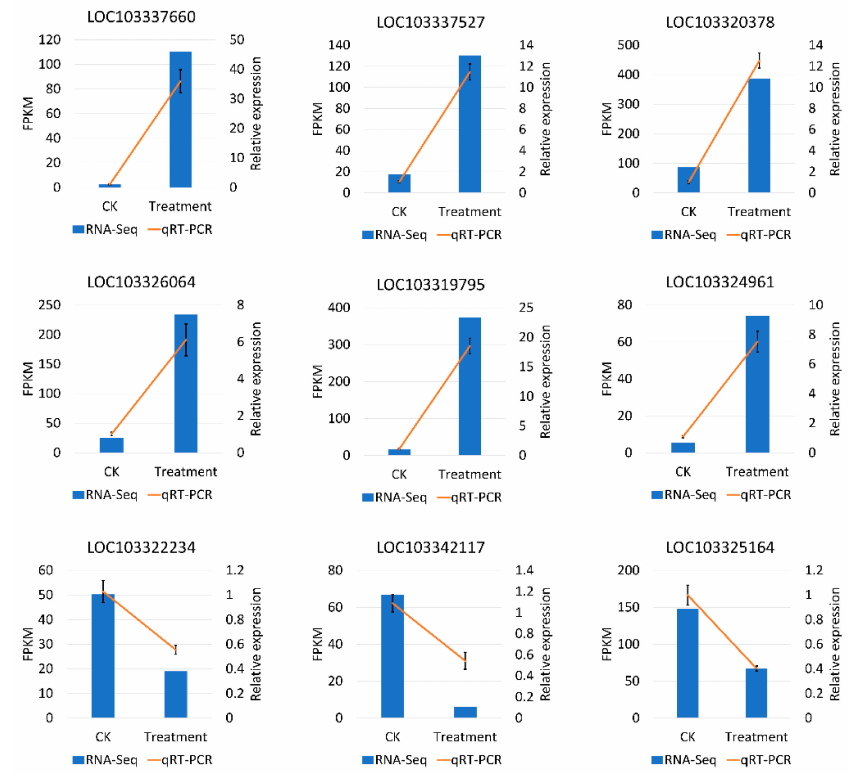
Figure 9. qRT-PCR validation of the expression level of nine DEGs may respond to the low temper- ature during flowering in P. mume . The x -axis means the two groups in this study, and the y -axis means the FPKM by RNA-Seq and the relative quantitative expression level by